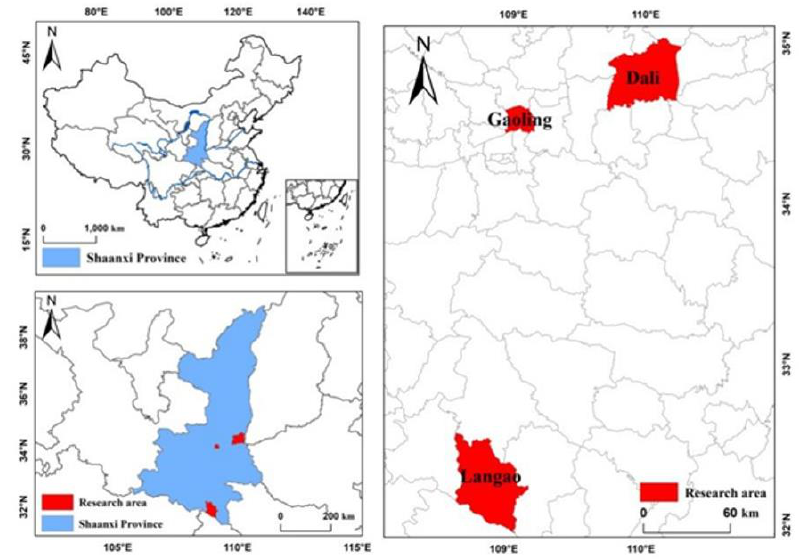
Figure 1. Map of the data source.